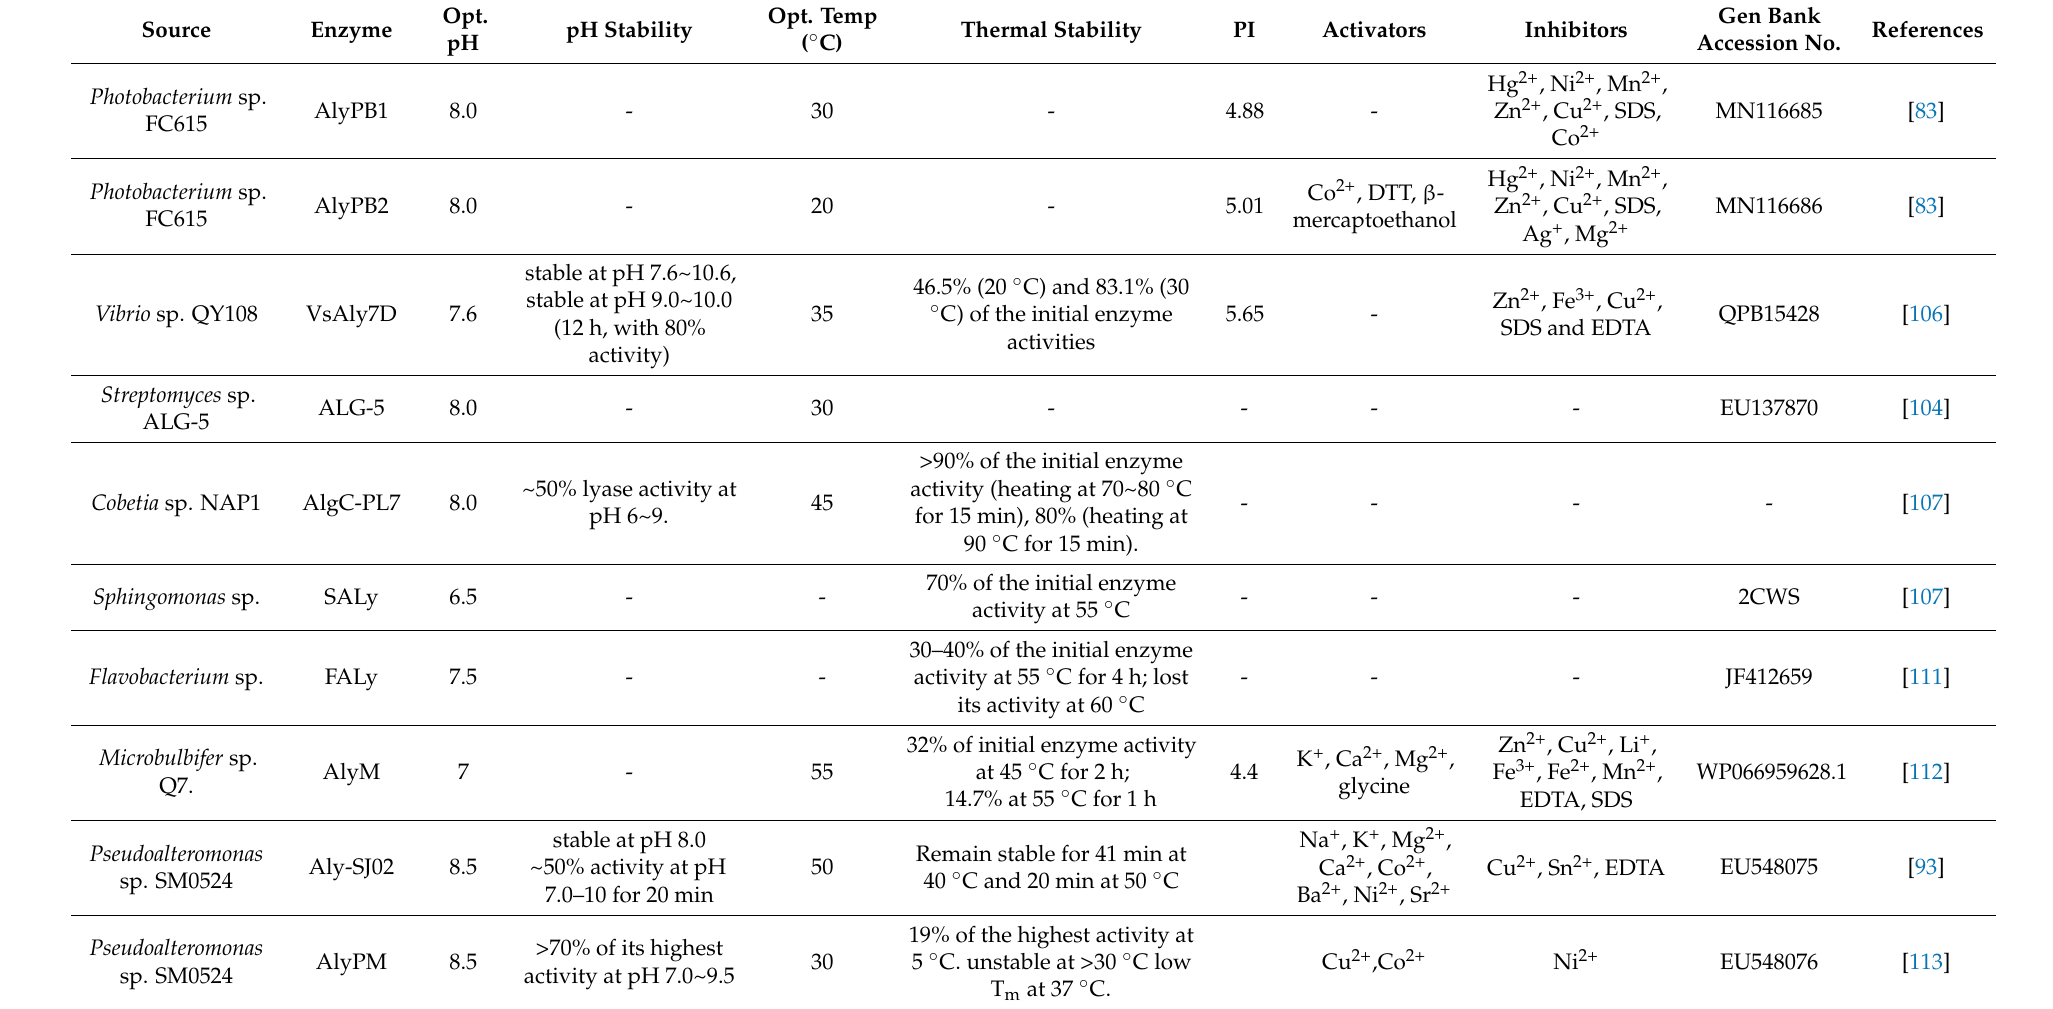
Table 2. Biochemical properties of alginate lyase purified from marine alginolytic bacteria. Source